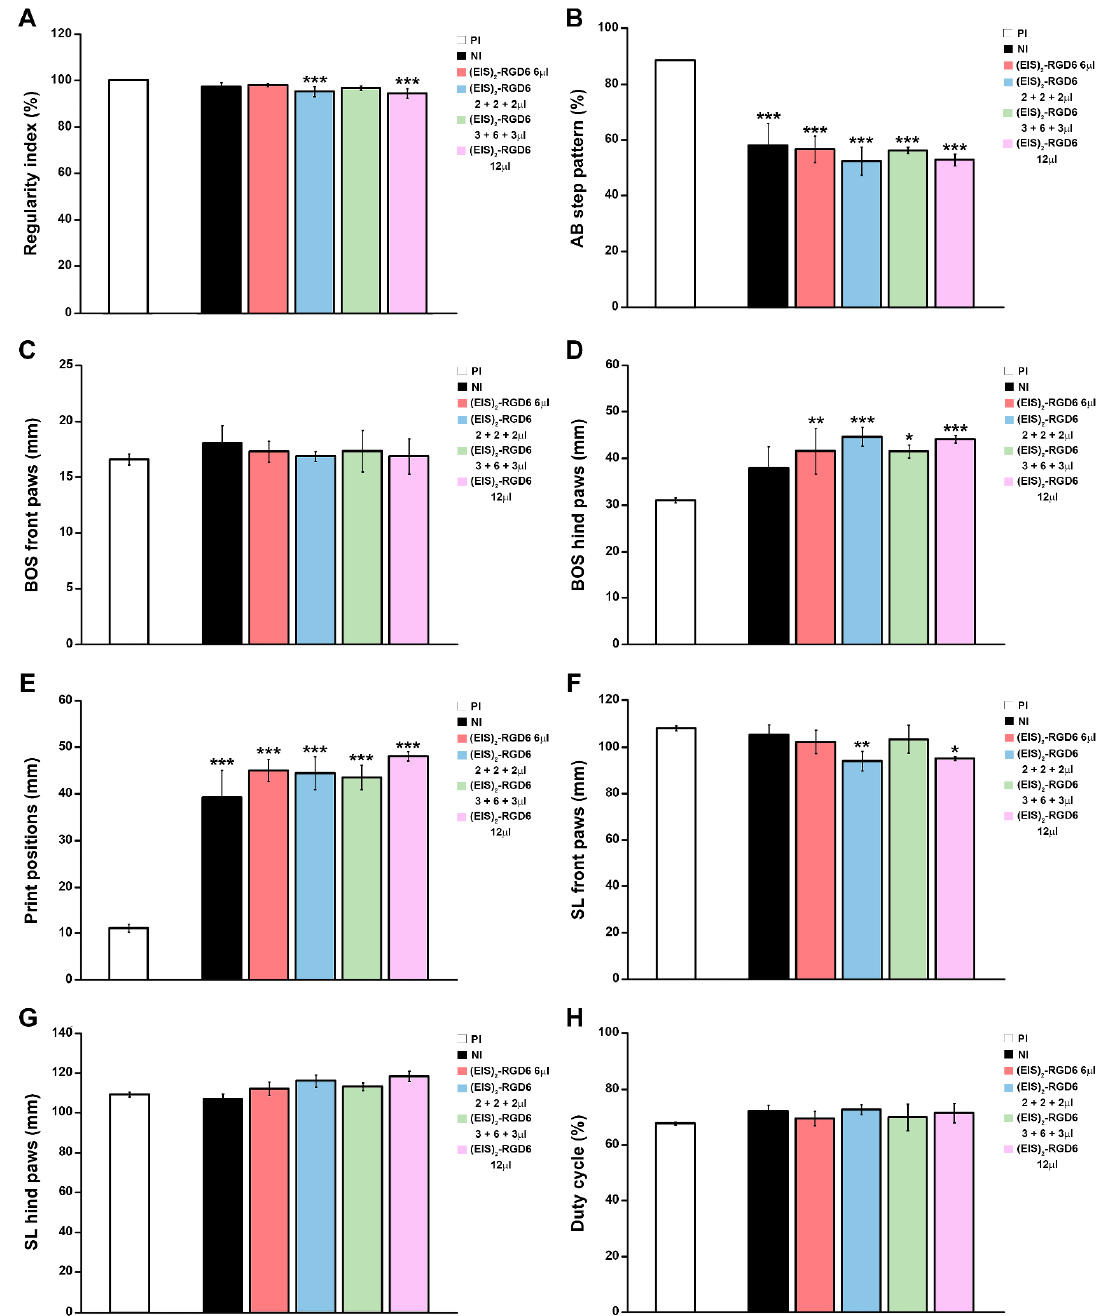
Figure 6. Determination of the injection system: Catwalk ® -based gait analysis IV. Graphs show